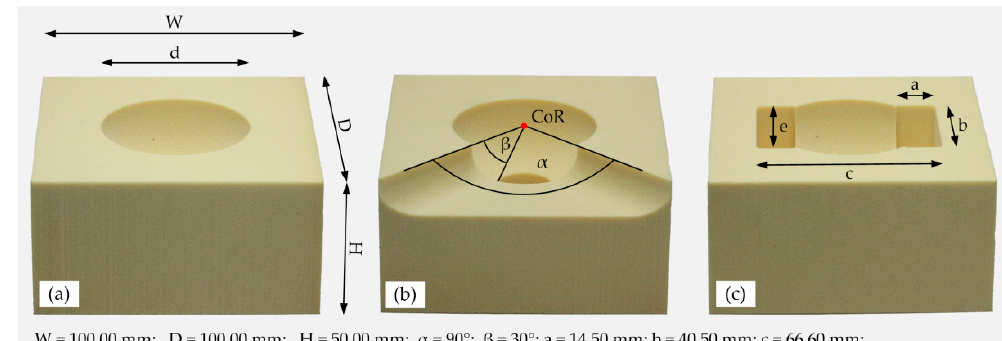
Figure 1. Polyurethane (PU) foam cavities for the experimental tests and the ideal geometry parameters associated with different cavity types. Three different cavity types were considered: ( a ) intact cavity (Intact); ( b ) a moderate superior acetabular defect (Defect 1), and ( c ) a two-point pinching cavity model (Defect 2).